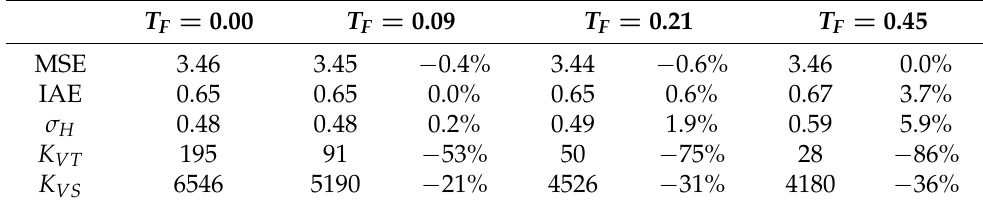
Table 3. Filtering impact on G 1 ( s )